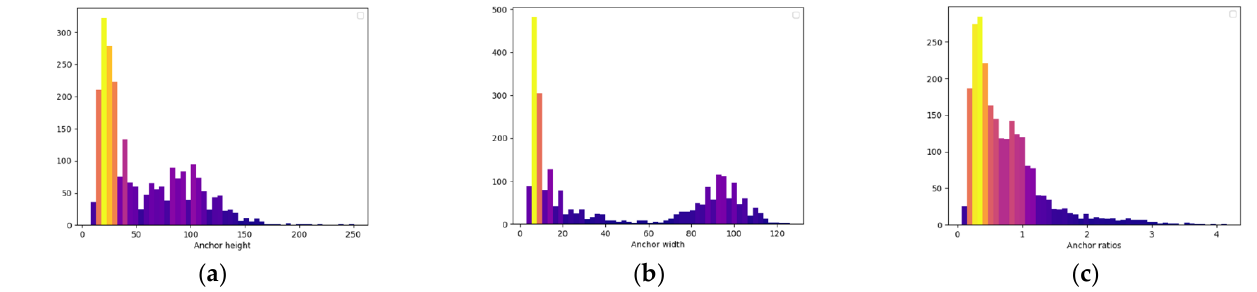
Figure 6. Size statistics of samples in collected dataset, the X-axis is the size of samples, the Y-axis is the number of samples: ( a ) anchor height statistics; ( b ) anchor width statistics; and ( c ) anchor ratio statistics. Table 1. Statistics of labeled data in different anchor scale ranges (%).